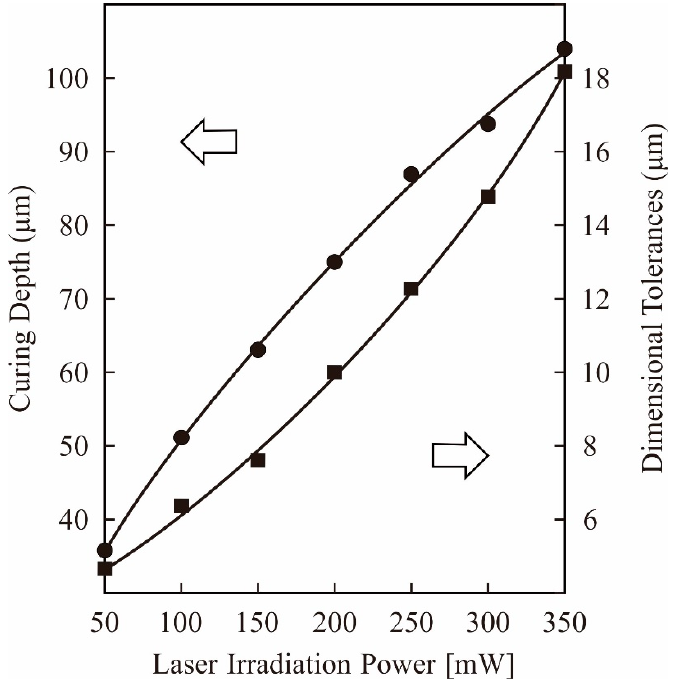
Figure 8. Corresponding values of the curing depth and dimensional tolerances for laser irradiation powers. Layer thickness and hole diameters were measured in the film specimens, as shown in Figure 2.